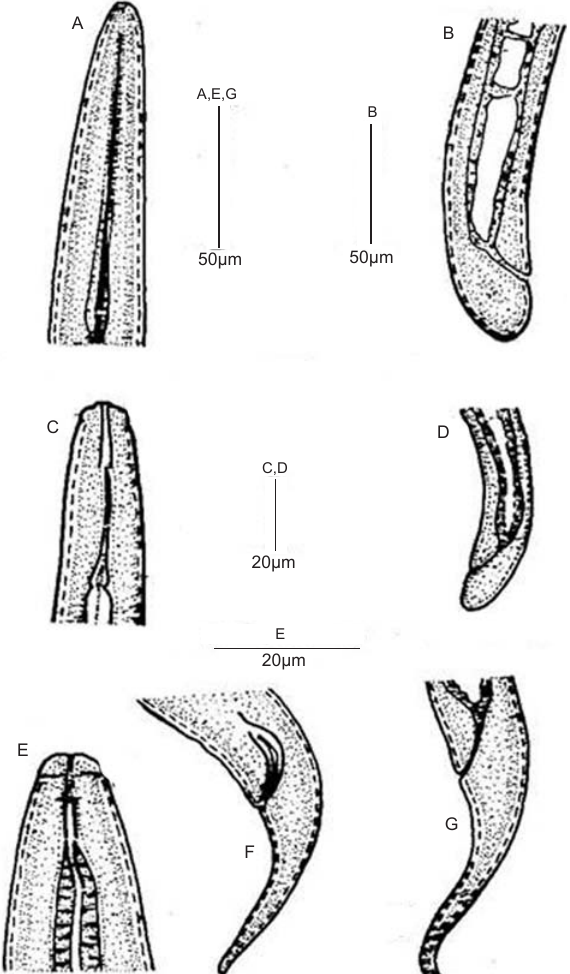
Figure 3. Paralongidorus rex (Andrássy, 1986) Hunt,1993 A - Anterior end; B - Posterior end. Sclerostylus karri Goseco, Ferris & Ferris, 1971 C - Anterior end; D - Posterior end. Dorylaimoides (L) akon Goseco Ferris & Ferris, 1976 E - Anterior end; F - Male Posterior end; G - Female